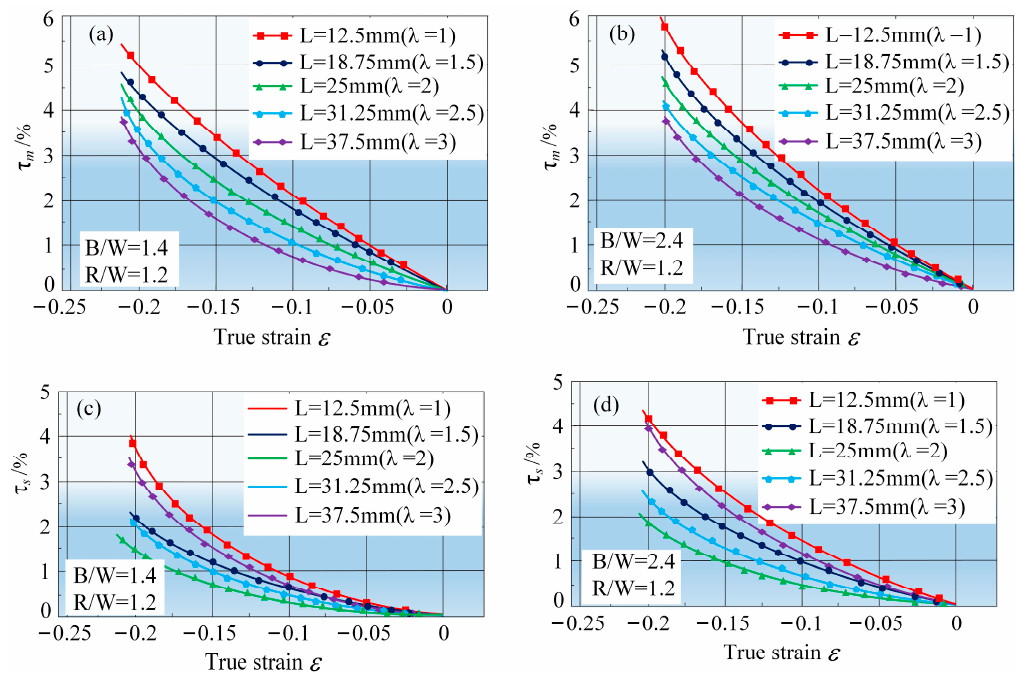
Figure 6. Effect of aspect ratio λ on the variation of τ m and τ s with true strain: ( a ) B/W = 1.4; ( b ) R/W = 1.2; ( c ) B/W = 2.4; ( d ) R/W = 1.2. During the compression of the cyclic sheet tensile–compression sample, B / W = 1.4, R / W = 1.2; B / W = 2.4, R / W = 1.2 were set to investigate the effect of the aspect ratio 𝜆 of